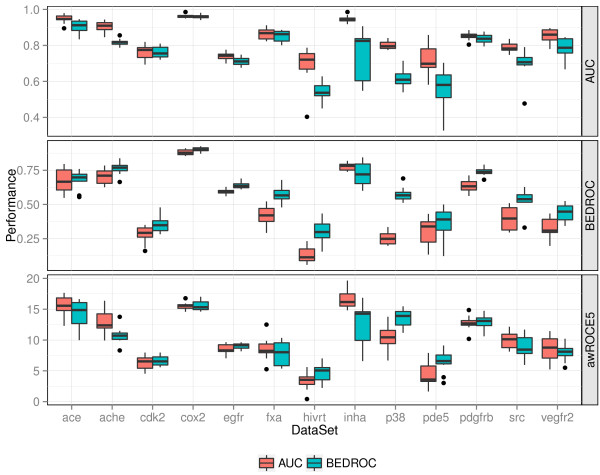
Performance of AUC and BEDROC optimized queries+. AUC, BEDROC and awROCE5% performance of the AUC and BEDROC optimized queries on the external splits of the 13 DUD data sets.